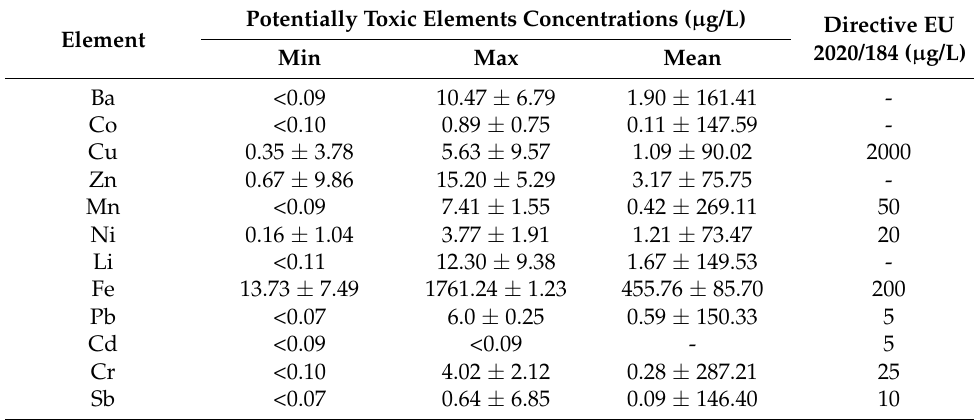
Table 1. Potentially toxic elements levels in drinking water samples.